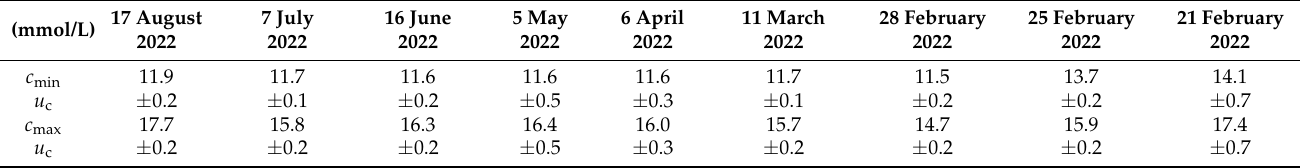
Table 3. Minimal and maximal citrate concentrations determined on a particular day in the blood collection tubes on the Milli-Q water model and their associated combined standard